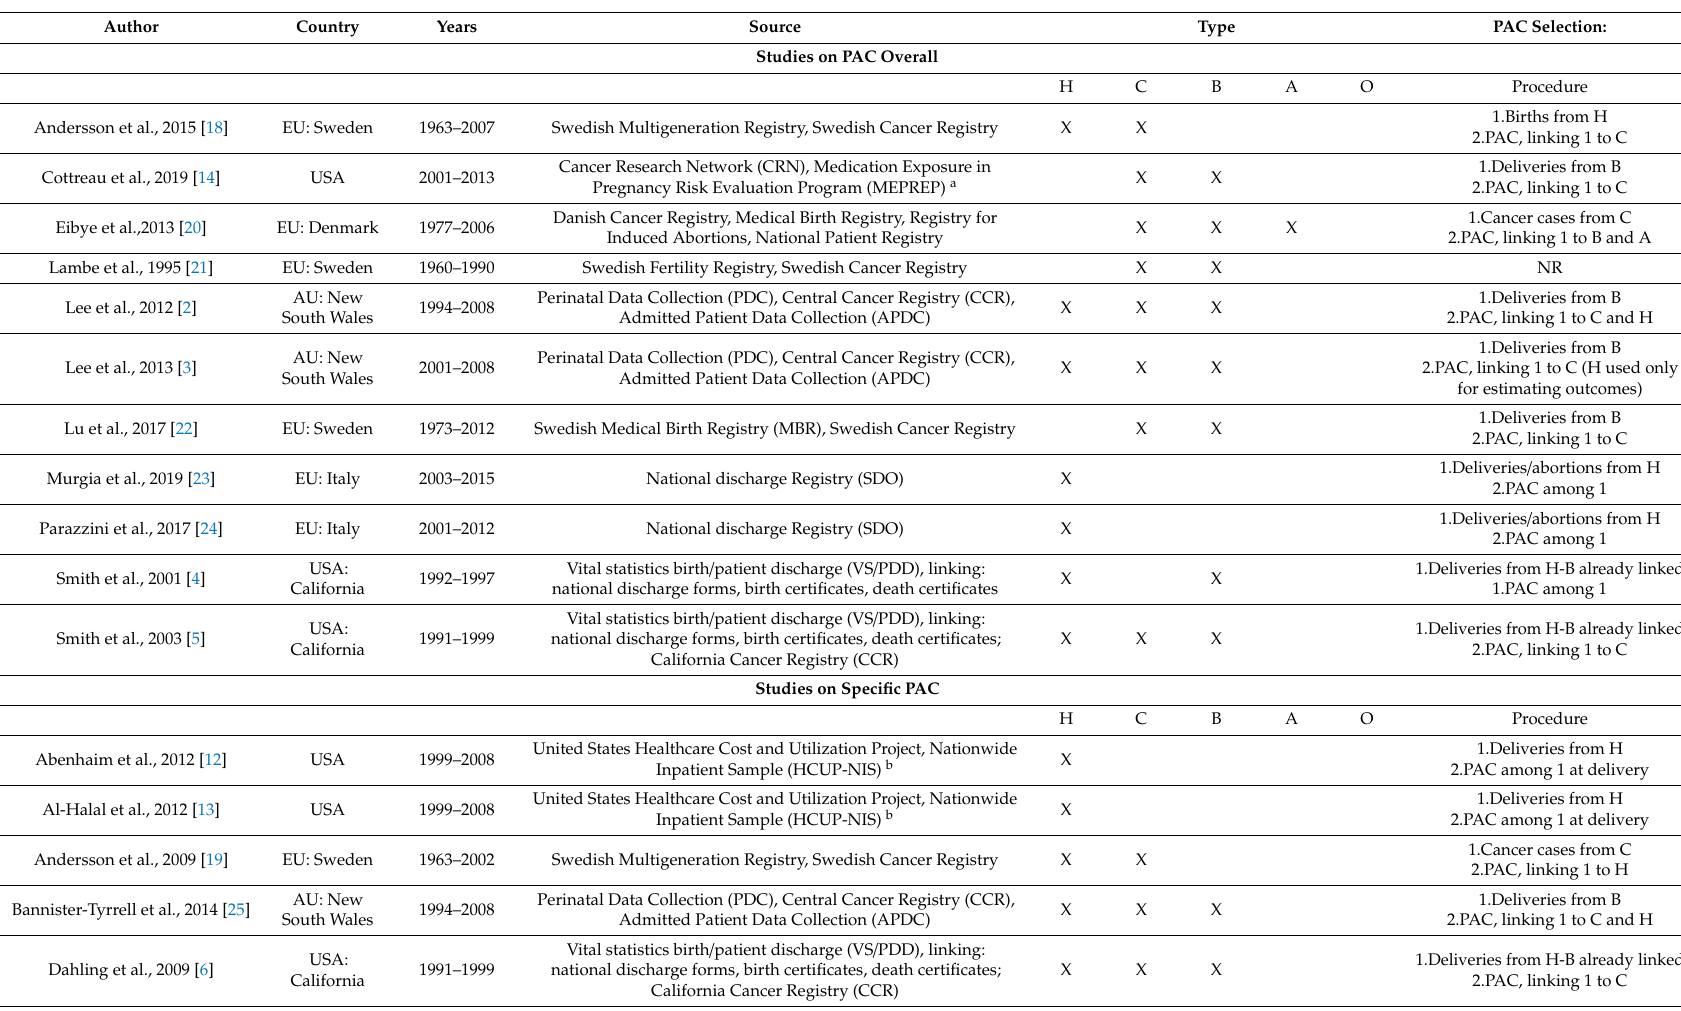
Table 1. Characteristics of the study, sources and procedure of identification of pregnancy-associated cancer (PAC). Studies on PAC overall and on specific